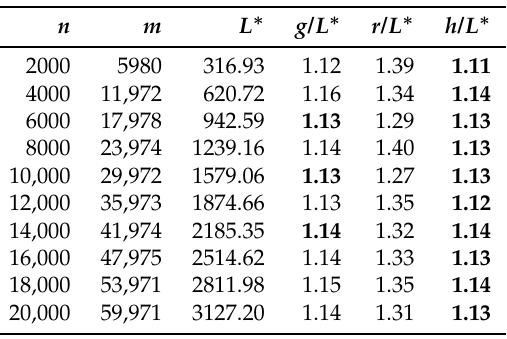
Table 1. Results for 0-Planar Graphs.